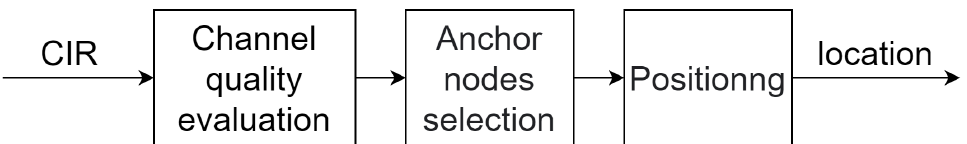
Figure 3. The framework of channel-quality-evaluation-based anchor node selection for UWB indoor